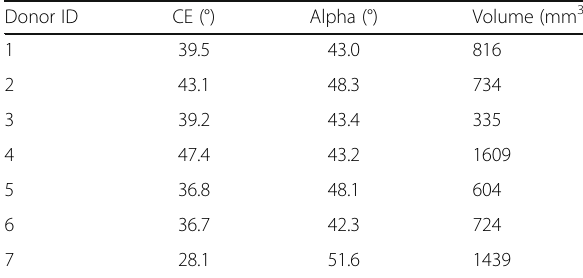
Table 1 Table showing the preoperative CE- and alpha angle and volumes of removed bone during ACH for the seven